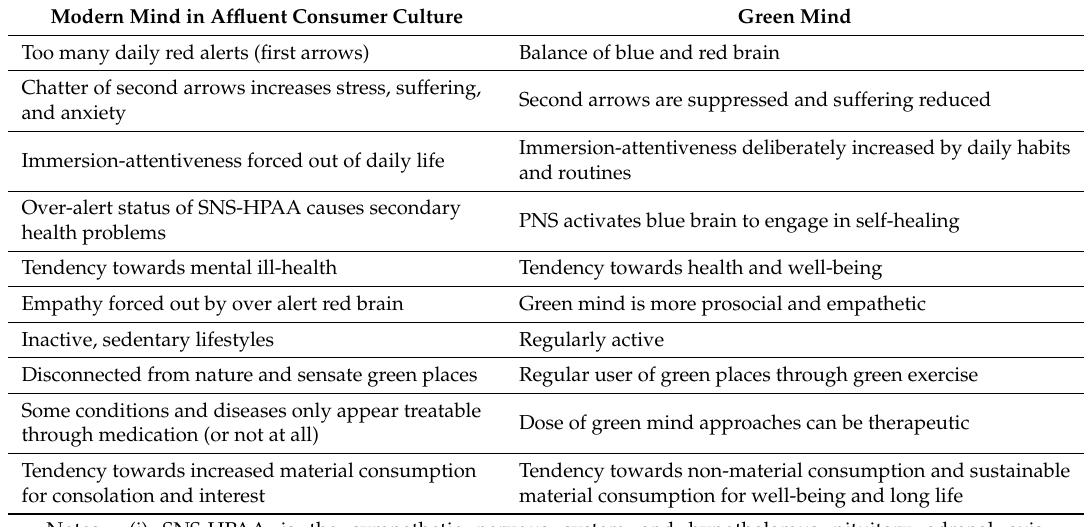
Table 2. Ten differences between mind typical of modern affluent culture and the green